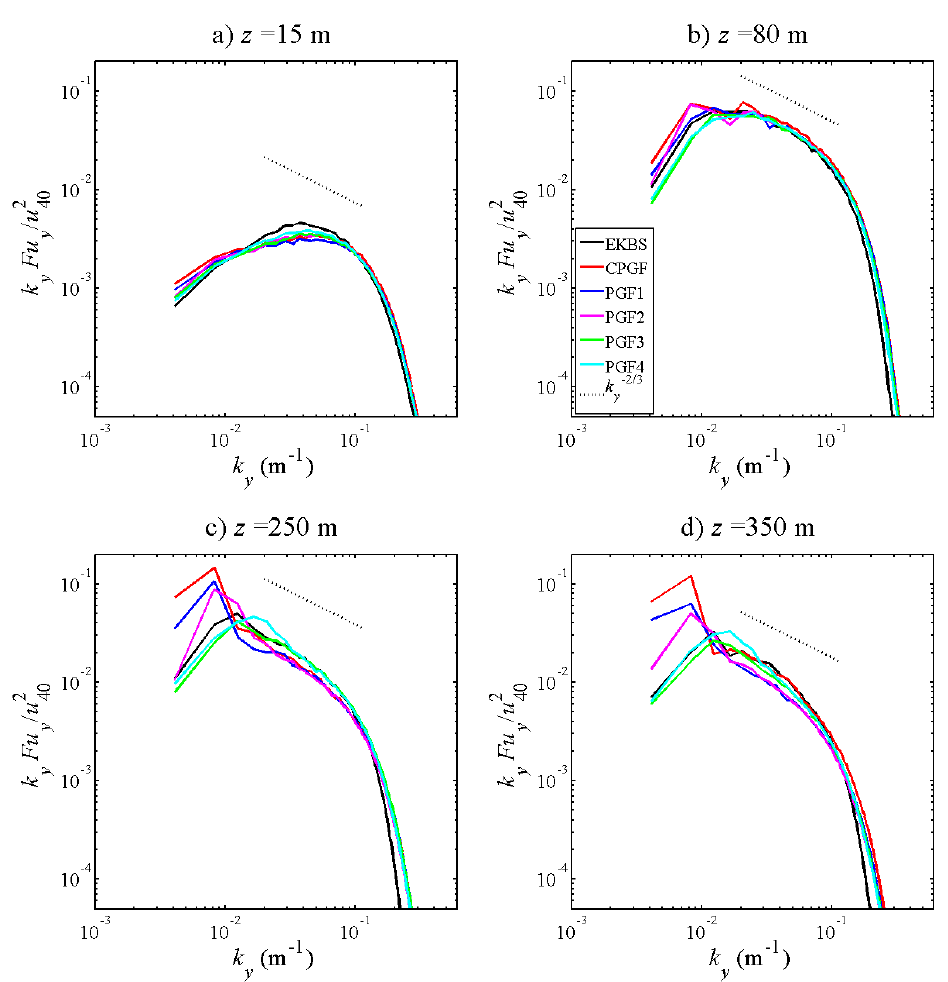
Figure 9. Spectral analysis of the u -velocity component for the boundary-layer simulations (1568 m × 1568 m × 800 m), at ( a ) z = 15 m, ( b ) z = 80 m, ( c ) z = 250 m and ( d ) z = 350 m. The black-point line represents the − 2/3 power line.